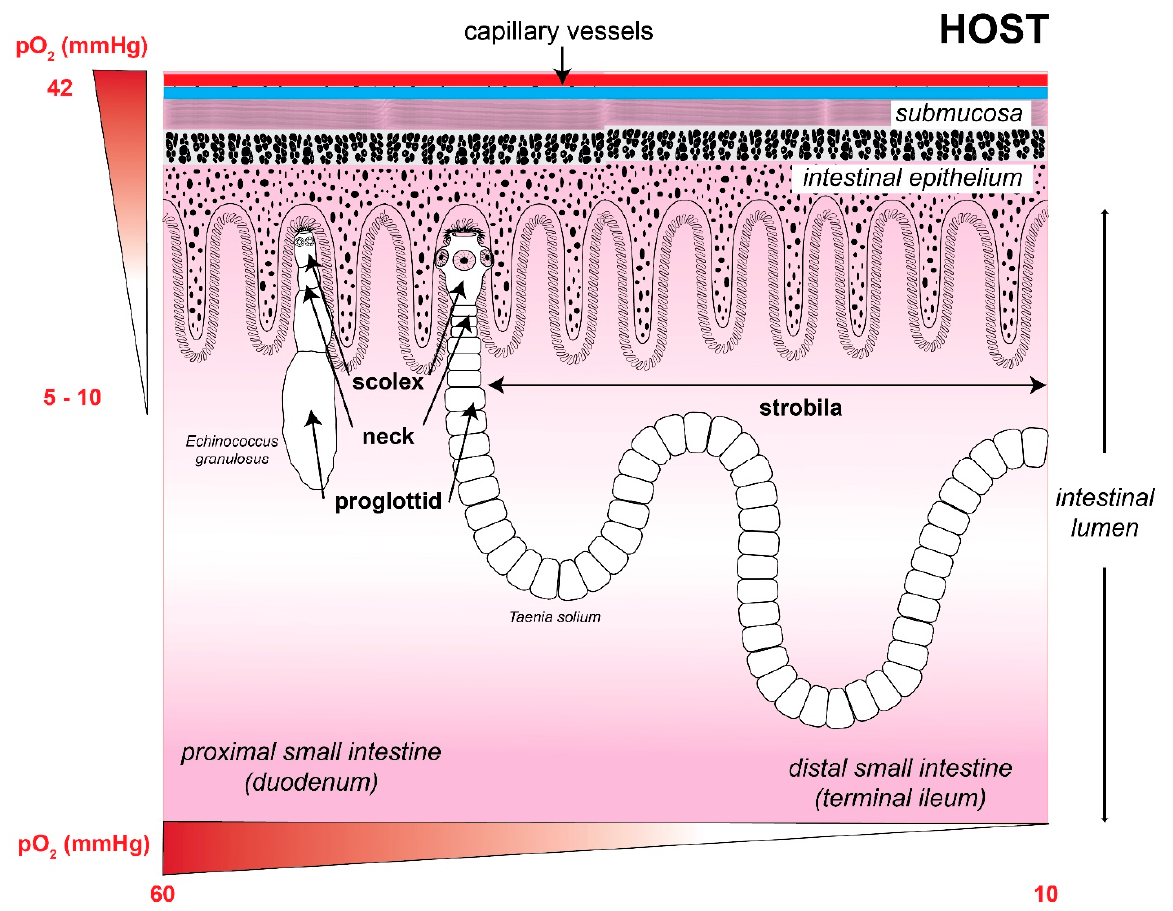
Figure 2. Adult form of the cestodes is exposed to the intestinal oxygen concentration. The image shows a structural drawing of the adult tapeworm form of Echinococcus granulosus (left; size range 2–7 mm) and Taenia solium (right; size range 2–7 m), attacking the intestinal epithelium of their definitive host. Oxygen tension in the intestinal tissue decreases the further away parasites are from the intestinal capillaries, while the oxygen concentration in the intestinal lumen decreases as parasites move towards the colon, where the environment is practically anaerobic. Oxygen concentrations were obtained from references [33–36]. The size of the parasites was obtained from the Laboratory Identification of Parasites of Public Health Concern website (https://www.cdc.gov/dpdx/ (accessed on 17 February 2022)). Table 1. Oxygen concentration during the life cycle of Taenia solium .